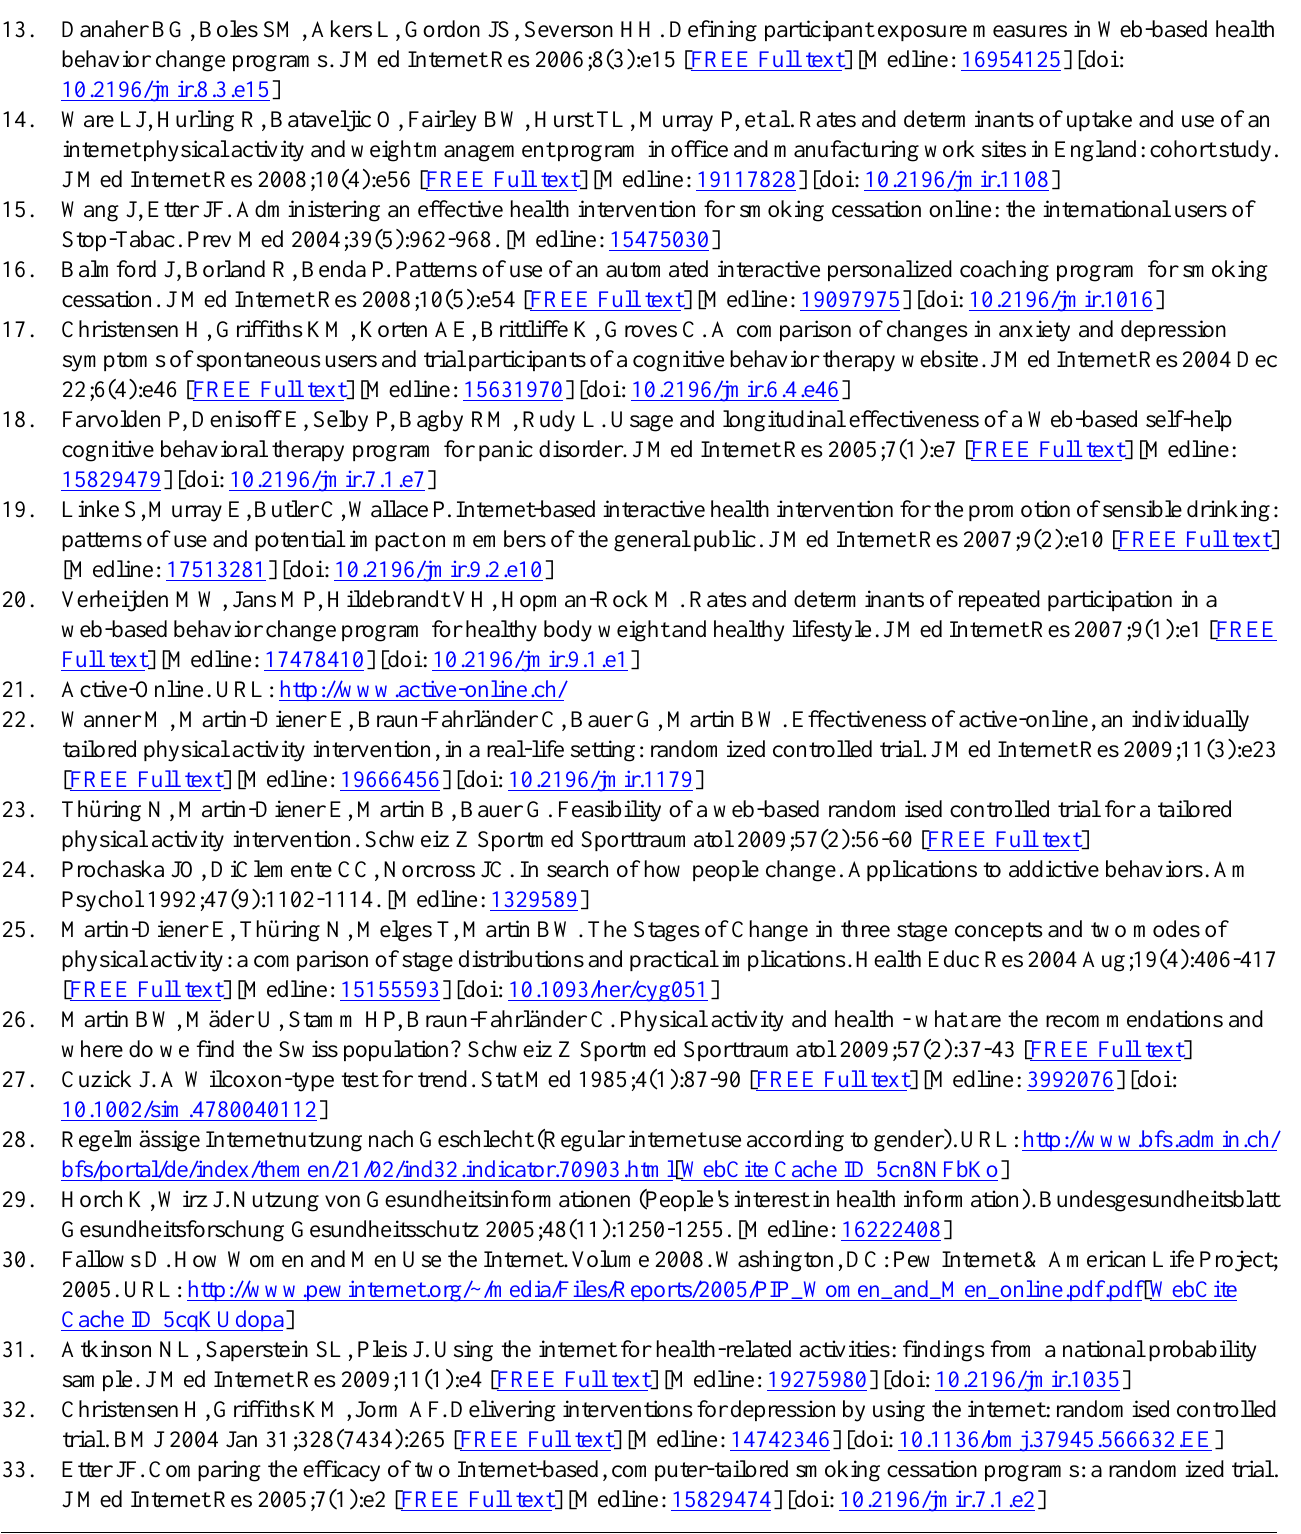
CI: confidence interval HEPA: health-enhancing physical activity IQR: interquartile range RCT: randomized controlled